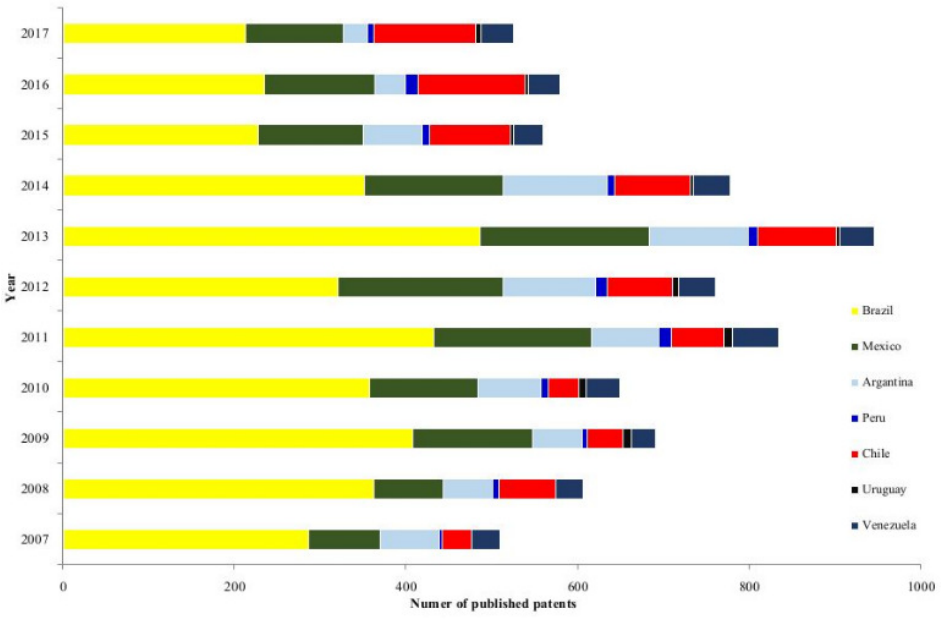
Figure 11. South American countries’ activity in the recent